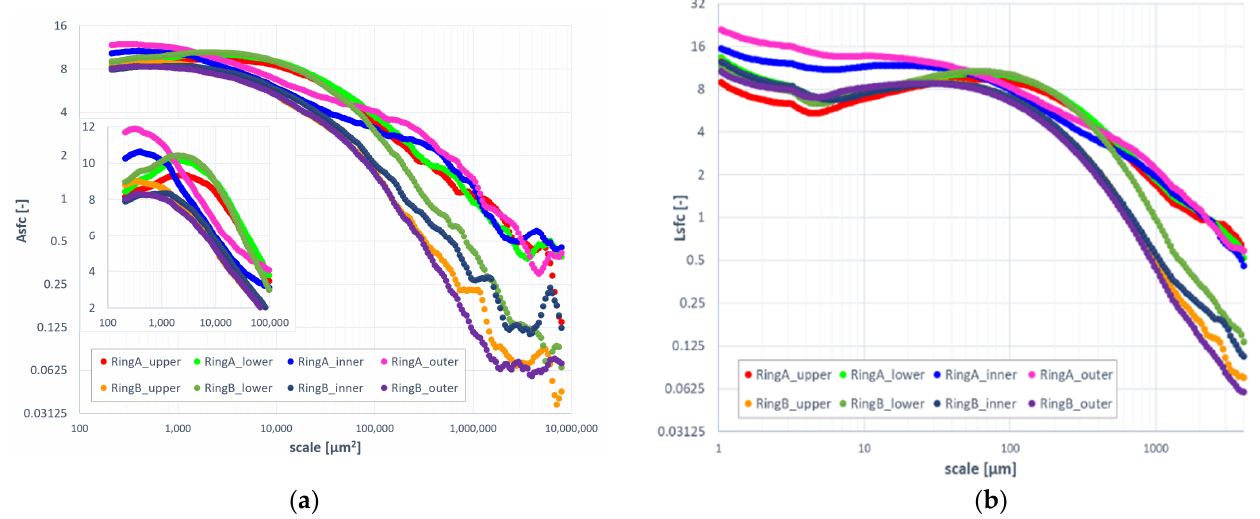
Figure 9. Evolution of area-scale ( a ) and length-scale ( b ) fractal complexity as a function of scale.